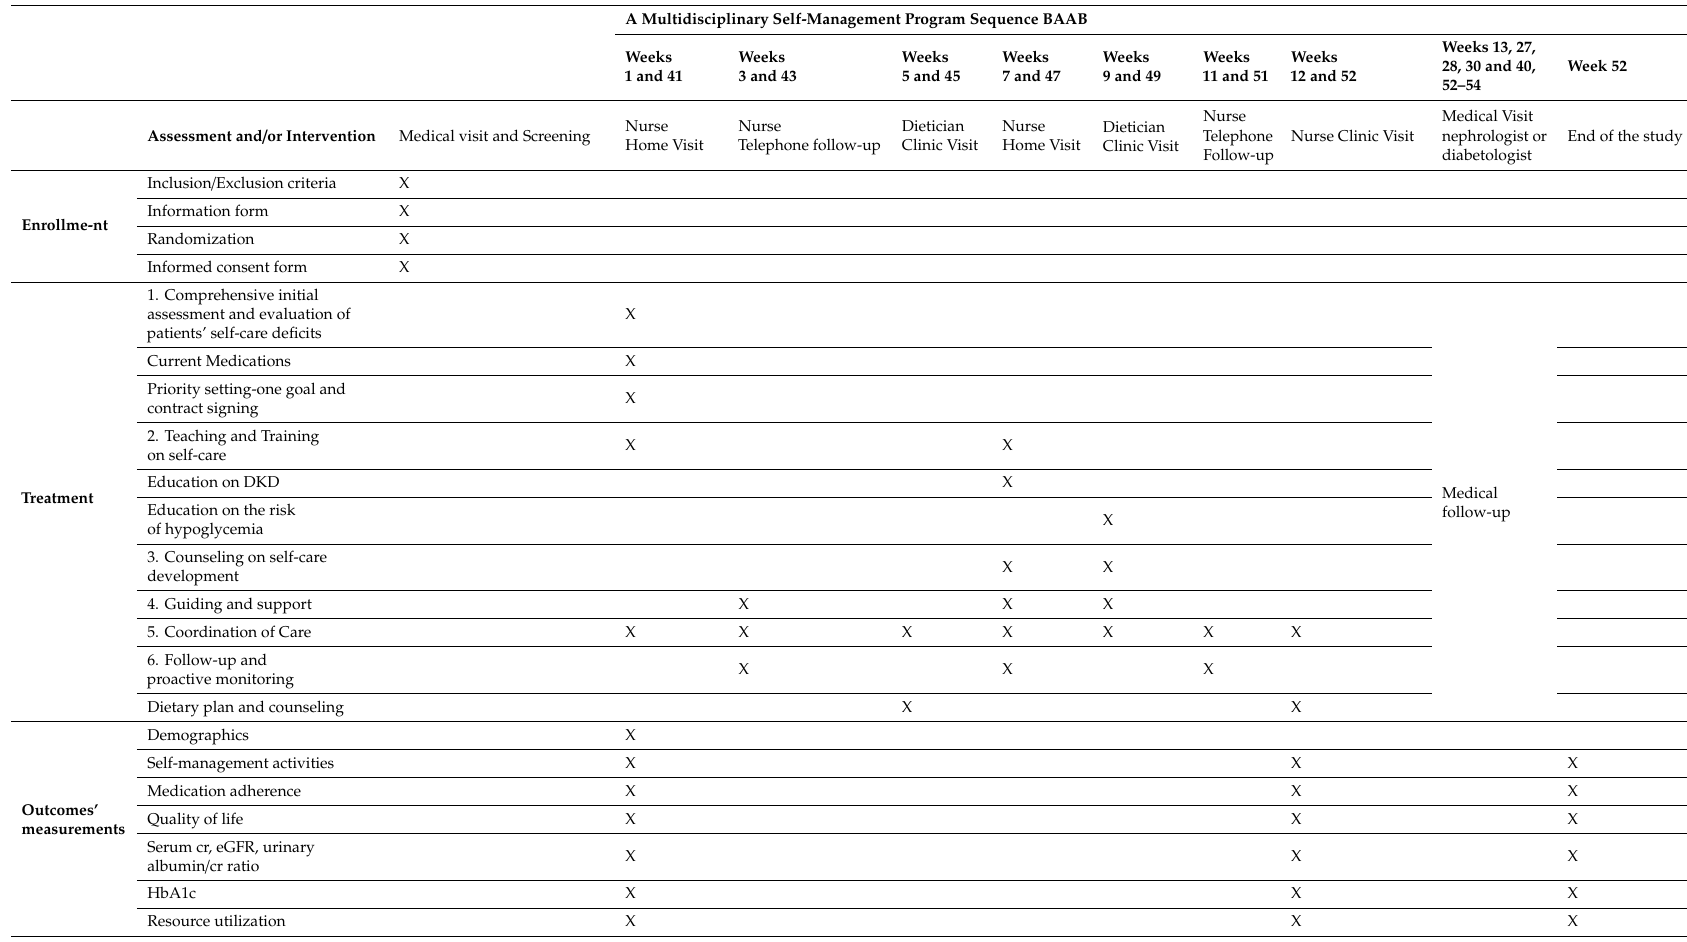
Table 2. The schedule, description, and outcome measurement of the multidisciplinary self-management program (MSMP) sequence-BAAB for patients with diabetic kidney disease